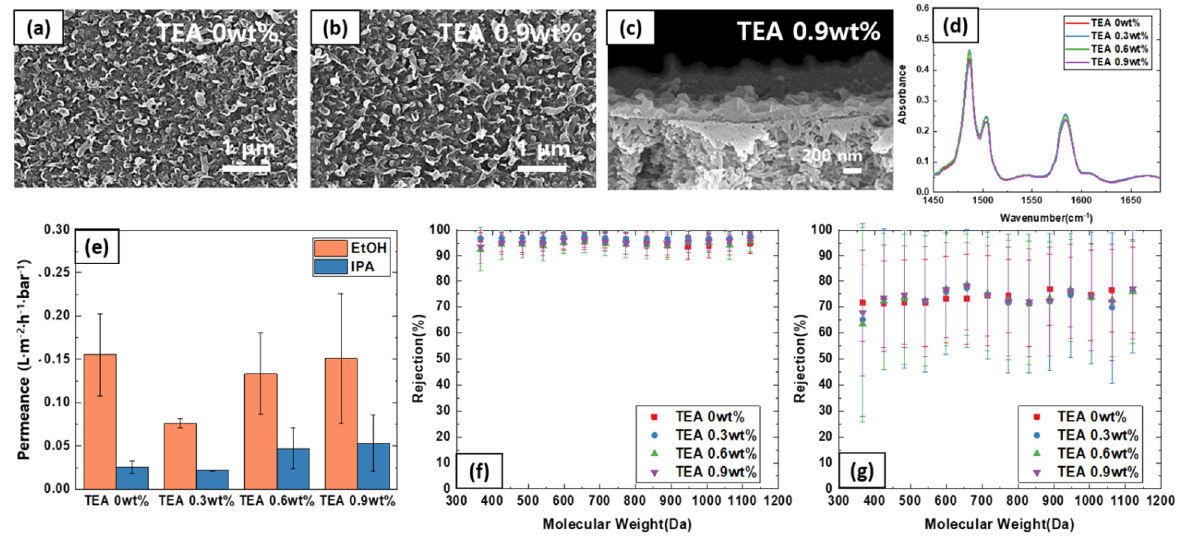
Figure 4. Effect of TEA additives in the aqueous phase on ( a , b ) surface SEM images, ( c ) cross-sectional image; ( d ) FTIR spectra. ( e ) solvent permeance ( f ) PPG rejection profile in EtOH, and ( g ) PPG rejection profile in IPA.